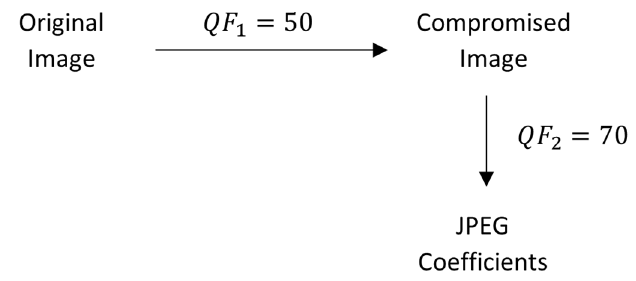
Figure 10. The “double-compressed” image.